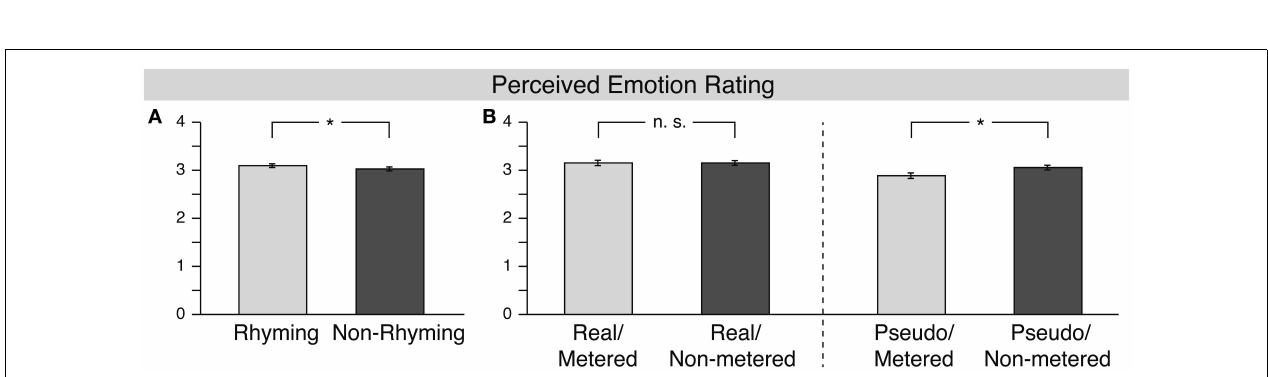
FIGURE 3 | Results for the “perceived emotion” rating. The (A) shows the main effect of rhyme, whereas the (B) depicts the interaction of lexicality and meter, with the left part showing the main effect of meter for real world stanzas and the right part showing the main effect of meter for pseudo-word